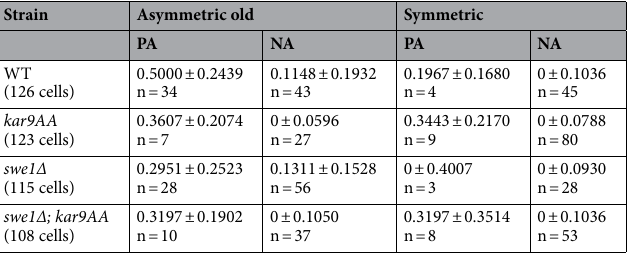
Table 1. Median Kar9 residence time in bud (normalized). Median ± absolute median